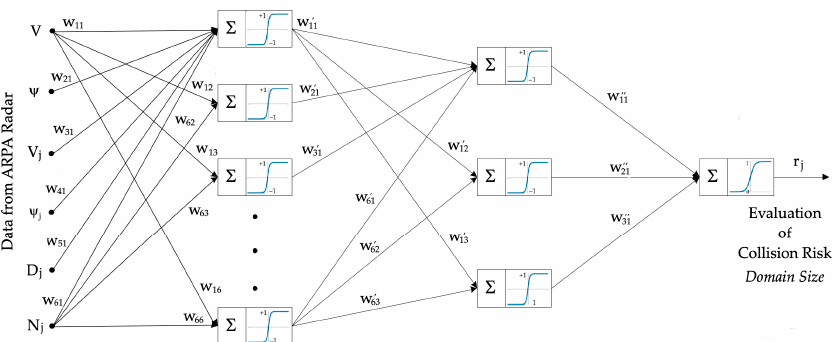
Figure 6. Neural network evaluating the risk of collision with j encountered ship and determining the size of the passing ship domain: w mn , w ′ mn , and w ′′ mn neuron weights of the first, second, and third layers, respectively.